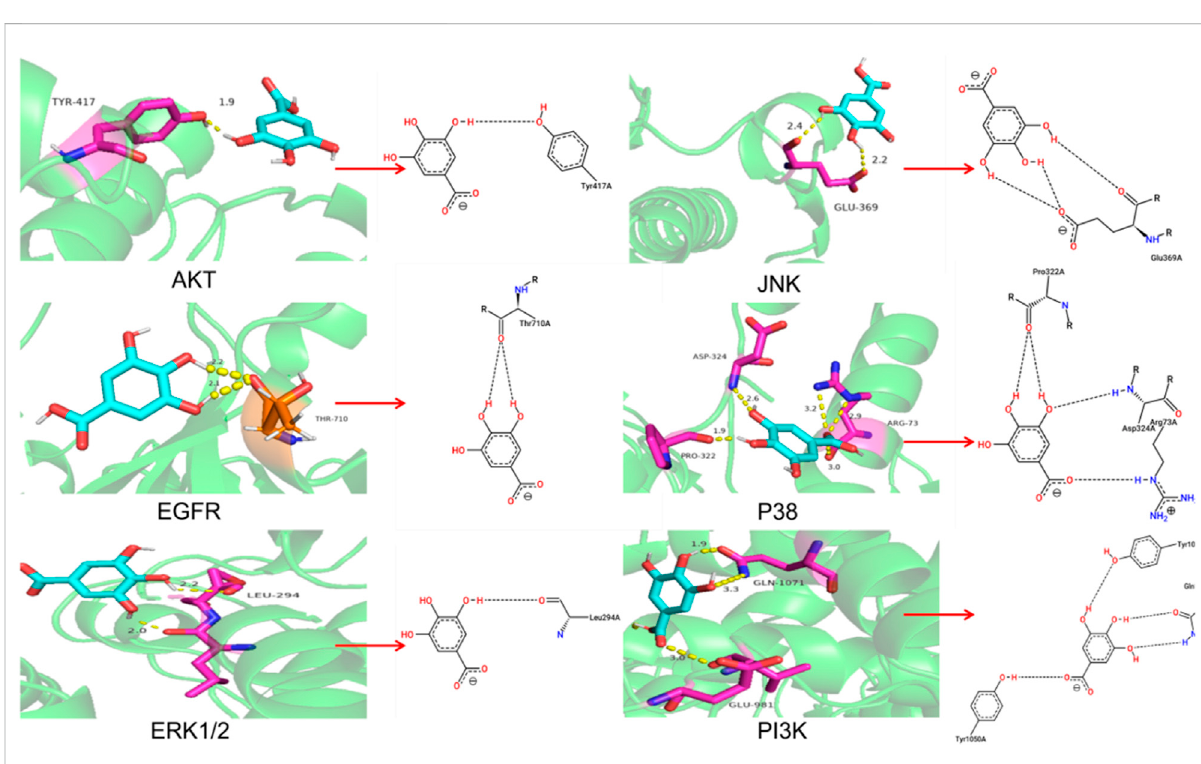
FIGURE 5 (A) Molecular docking diagram of GA and PI3K, AKT, EGFR, ERK1/2, JNK, and